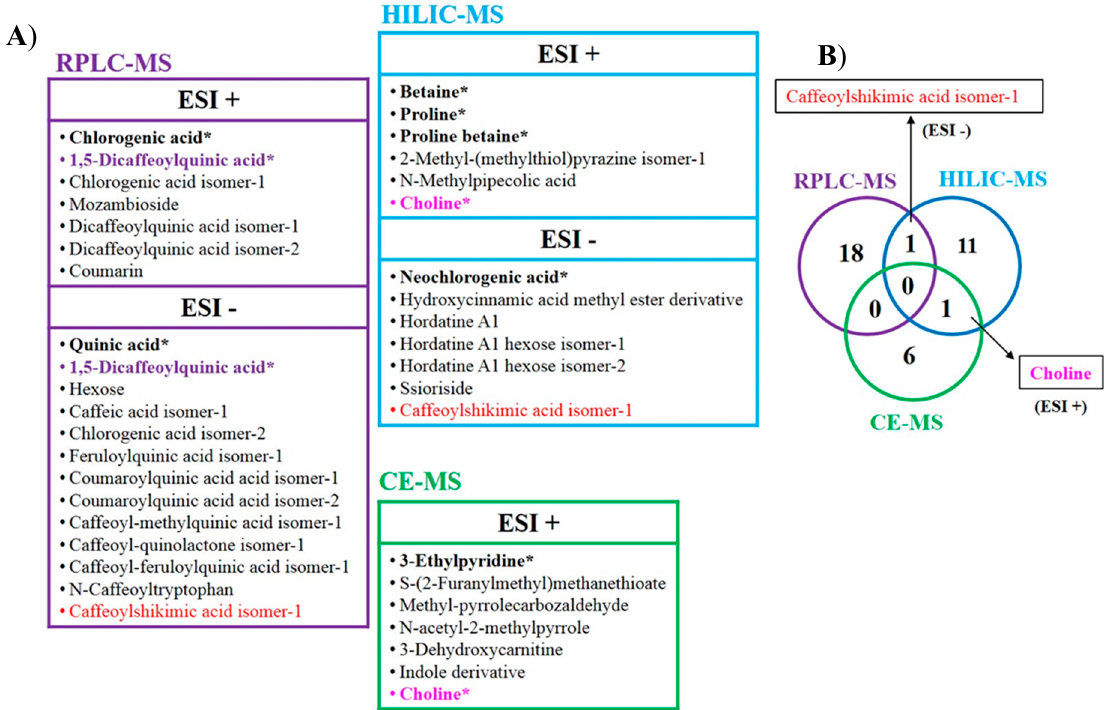
Figure 3. ( A ) List of metabolites tentatively identified by the integrated untargeted metabolomics multiplatform based on HILIC-MS, RPLC-MS [25] and CE-MS [26]. Those metabolites common in two platforms are highlighted using different colors. Metabolites unequivocally identified for each platform by the injection of standards (matched retention/migration times and MS/MS spectra fragmentation) are marked in bold and with an asterisk. ( B ) Venn diagram displaying the total number of different metabolites tentatively identified by the untargeted multiplatform proposed and those common to two platforms.